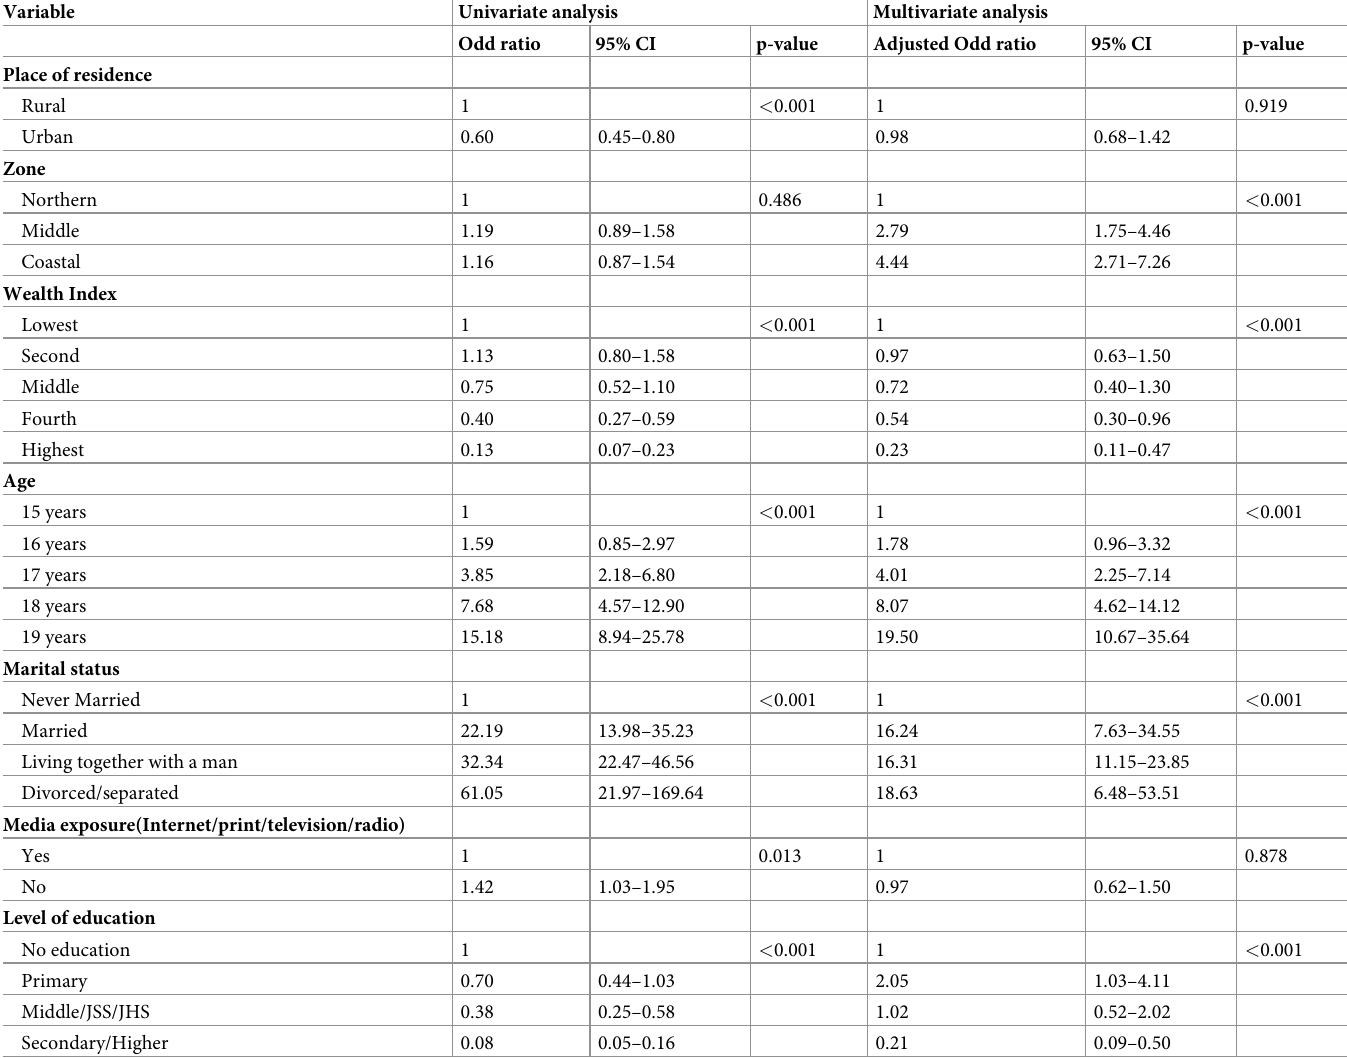
Table 5. Association of demographic factors with adolescents (aged 15–19 years)